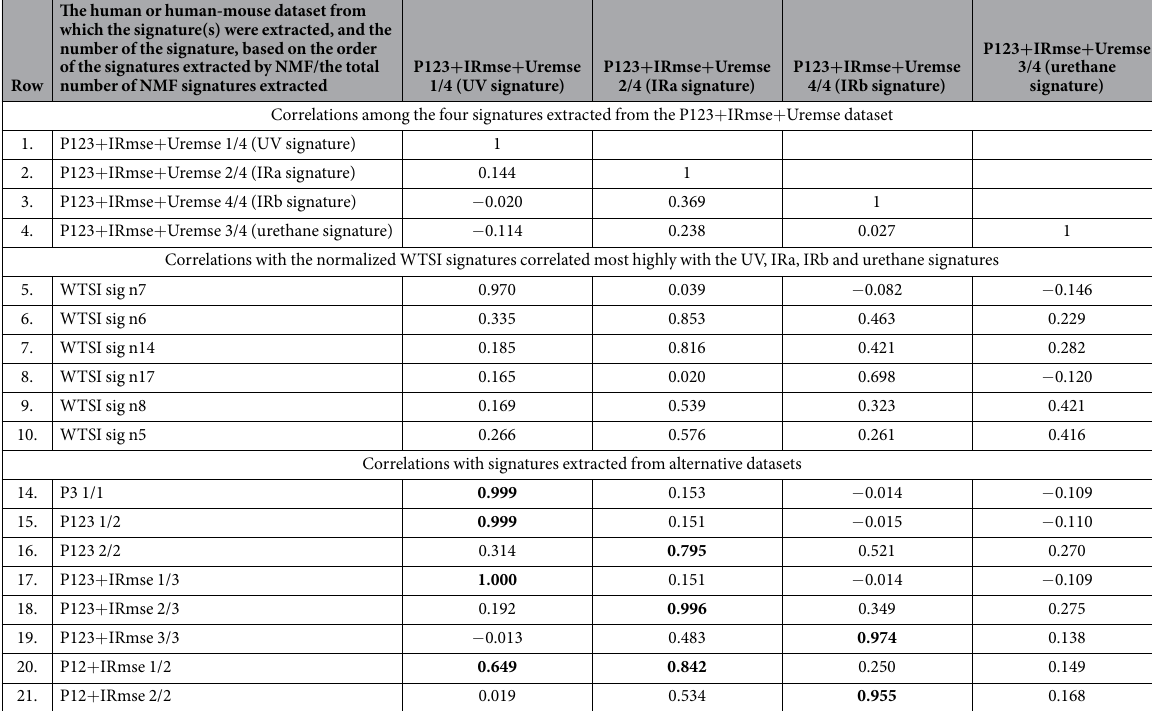
Comparing the IRa, IRb and UV signature results with radiation-associated signatures extracted from mouse IR-induced malignancies. In prior work, IR-associated signatures were iden- tified using mouse data for 192-mutational types (i.e., taking account of the strand in that prior work along with the 96 trinucleotide-based mutation types considered here to facilitate comparisons with the WTSI and COSMIC signatures) 4 , and without normalization. Differences between the signatures obtained in that prior study and those identified here are potentially due to the use of mouse-only versus pooled mouse-human data, the use of un-normalized versus normalized data, and the number of mutational types considered. Rows 1–5 in Table 2 shows pair-wise correlations between the UV, IRa, IRb, urethane signatures and new signatures from the normalized IRmse dataset (which does not include human data and no data from the urethane-treated mice). This dataset is the normalized, 96-mutational type counterpart of the un-normalized, 192-mutational type dataset used in our Cell Reports (CellR) paper 4 . Rows 1–2 give correlations when two signa- tures are extracted, and rows 3–5 give correlations when three signatures are extracted from the IRmse dataset. In Table 2, the IRa signature has a correlation of 0.921 with signature 1/3 (row 3), the IRb signature has a correlation of 0.980 with signature 3/3 (row 5), and the UV signature has a correlation of 0.779 with signature 2/3 (row 4). That third correlation is higher than expected given that none of the mouse IR-induced malignancies were skin cancers and these cancers arose in mice that were not exposed to UV. However, it supports the possibil- ity that one of the three previously reported IR-related mutational signatures 4 represents a process also operating in cancers induced by UV radiation. This possibility is consistent with the statistically significant correlation of 0.649 (p-value < 0.0001) between signature 1/2 extracted from the P12 + IRmse dataset (containing no data from the skin cancer of Patient 3), and the UV signature (Table 1, row 20). The low correlations of the urethane signature with signatures 1/3, 2/3 and 3/3 (rows 3–5 in Table 2: cor- relations of 0.240, − 0.017, and 0.042 further supported by the Table 1, the row 4 low correlations of the ure- thane signature with the UV, IRa and IRb signatures: − 0.114, 0.238 and 0.027) suggest that urethane-mediated mutagenesis involves different mechanisms. Finally, in Table 2, rows 6–8, correlations are shown for the UV, IRa, IRb and urethane signatures with three signatures extracted from the un-normalized 96-type WES data for the IR-exposed mice (the CellR dataset here- after, which is the un-normalized counterpart of the IRmse dataset). The highest correlation in each of the first three columns of rows 6–8 is considerably lower than the corresponding highest correlation in rows 3–5. This is to be expected since the correlations in rows 3–5 are between signatures extracted from compatibly normalized datasets, whereas this is not the case for the correlations in rows 6–8.